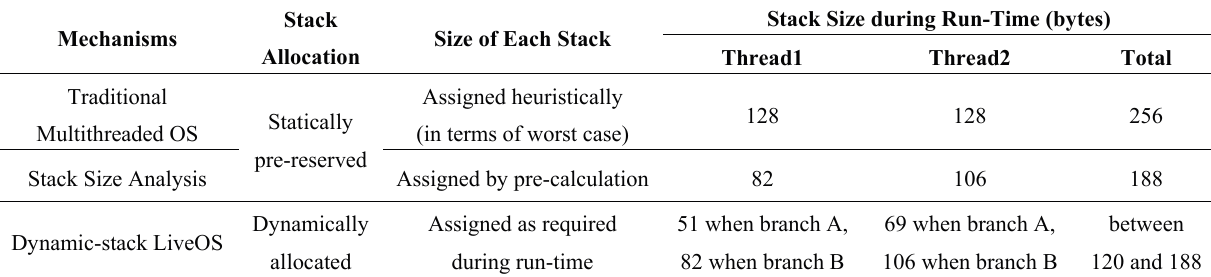
Table 3. Stack memory size required by running the threads in Figure